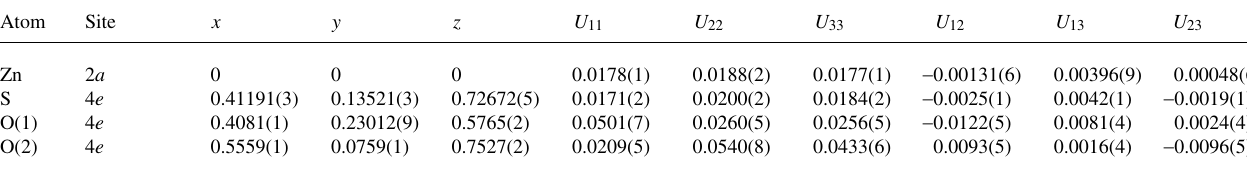
Table 6. Atomic coordinates and displacement parameters (in Å 2 )